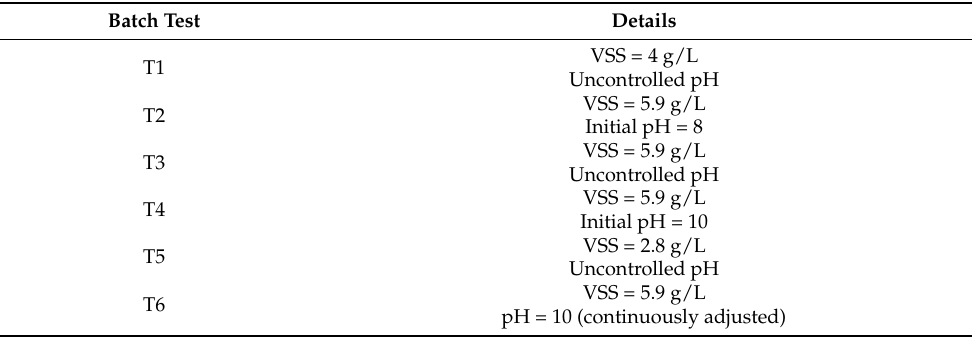
Table 1. Details of the performed batch fermentation